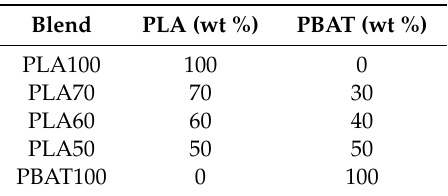
Table 1. Composition of poly (lactic acid) (PLA) and poly (butylene adipate-co-terephthalate) (PBAT) in the